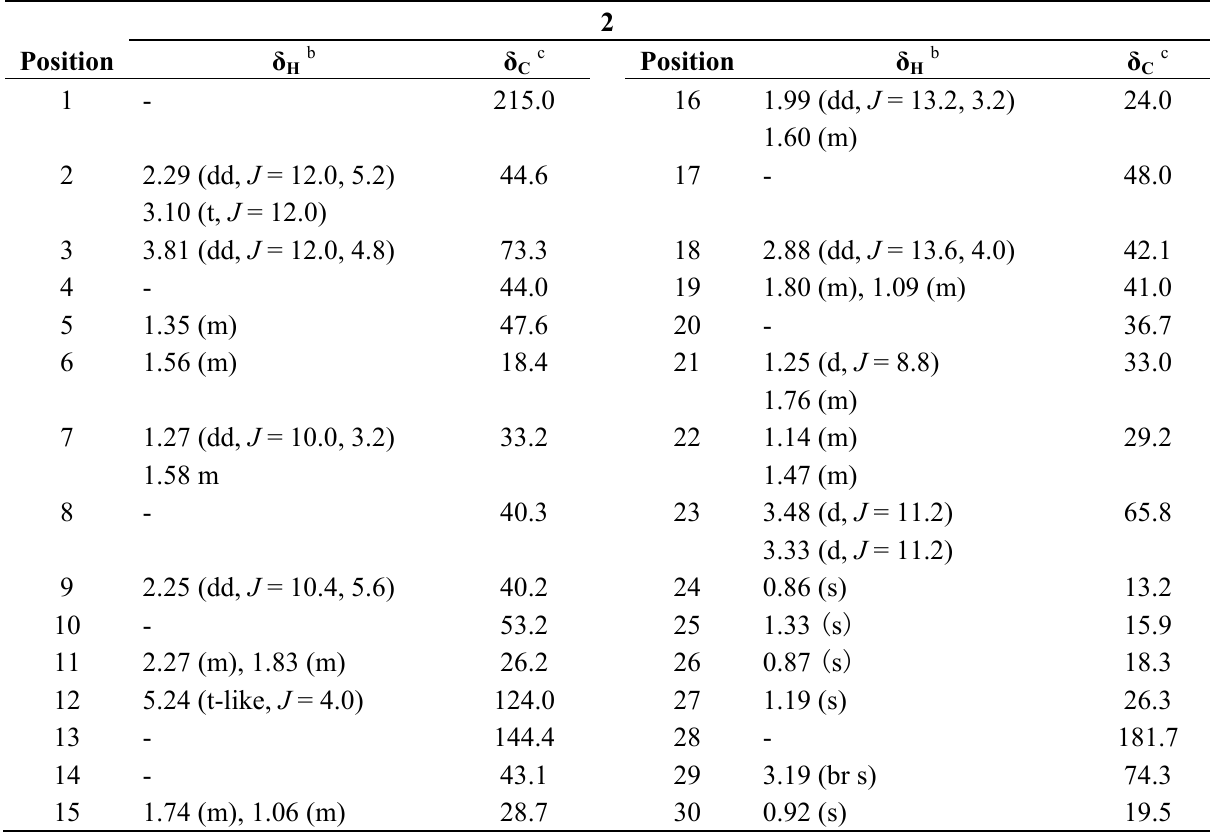
Table 2. 1 H-NMR and 13 C-NMR spectroscopic data a (  in ppm, J in Hz) of compound 2 in CD OD. 3